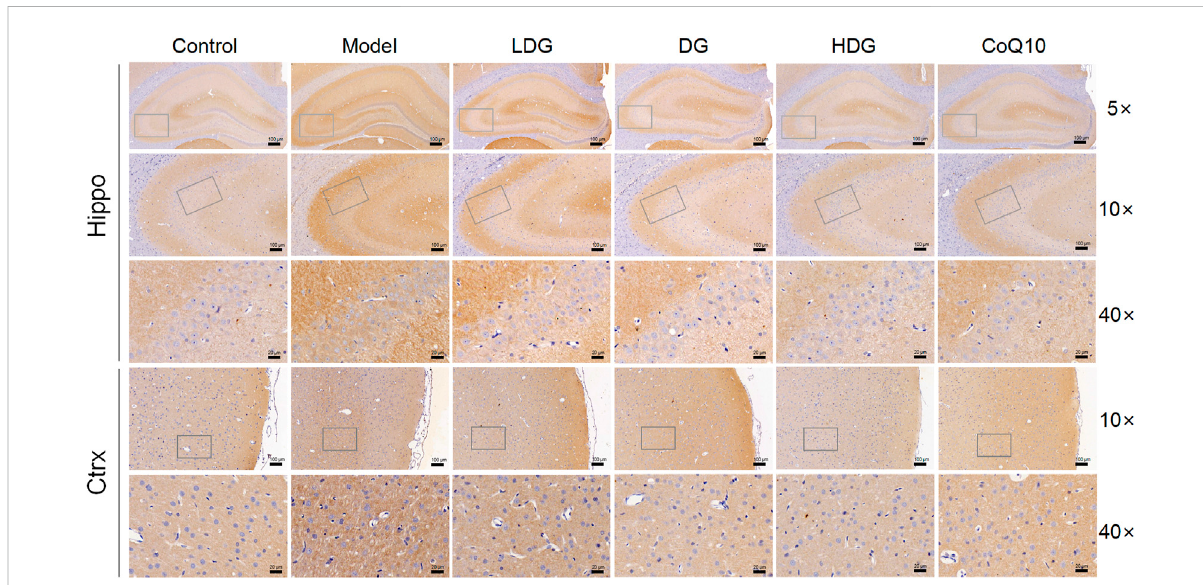
FIGURE 7 Immunohistochemical staining for GABABR2 in the hippocampal CA3 region (×5, ×10, ×40 magni fi cation) and the prefrontal cortex stromal layer (×10, ×40 magni fi cation) of rats.